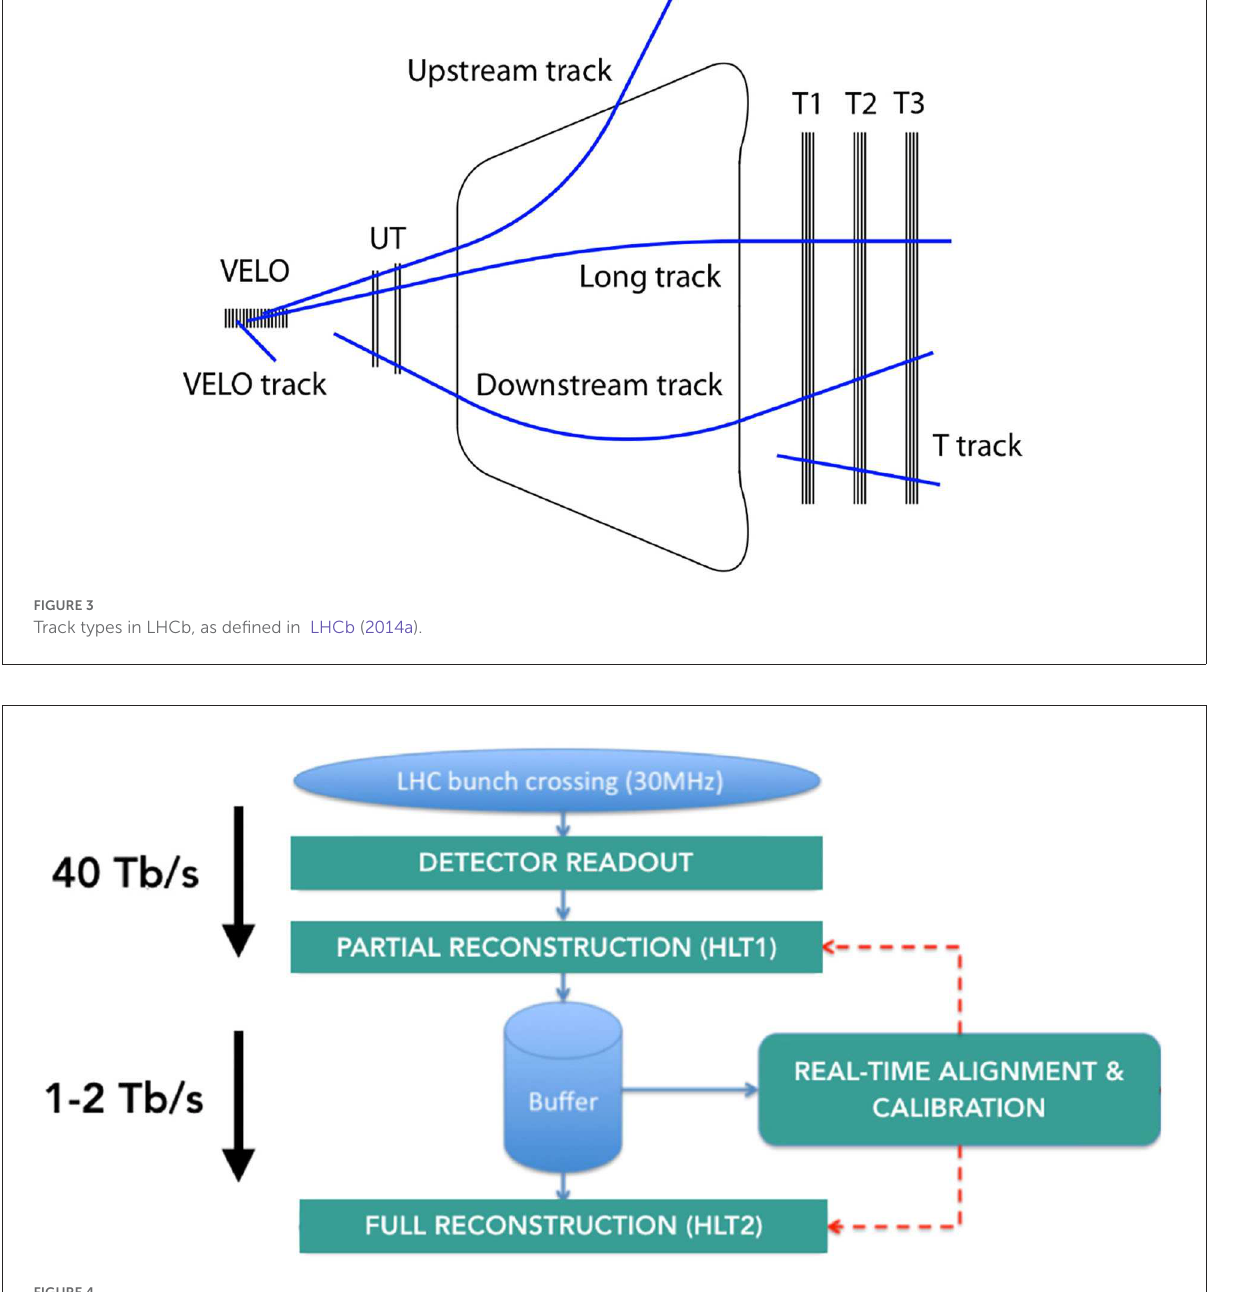
Downstream tracks. The remaining tracklets are then called T-